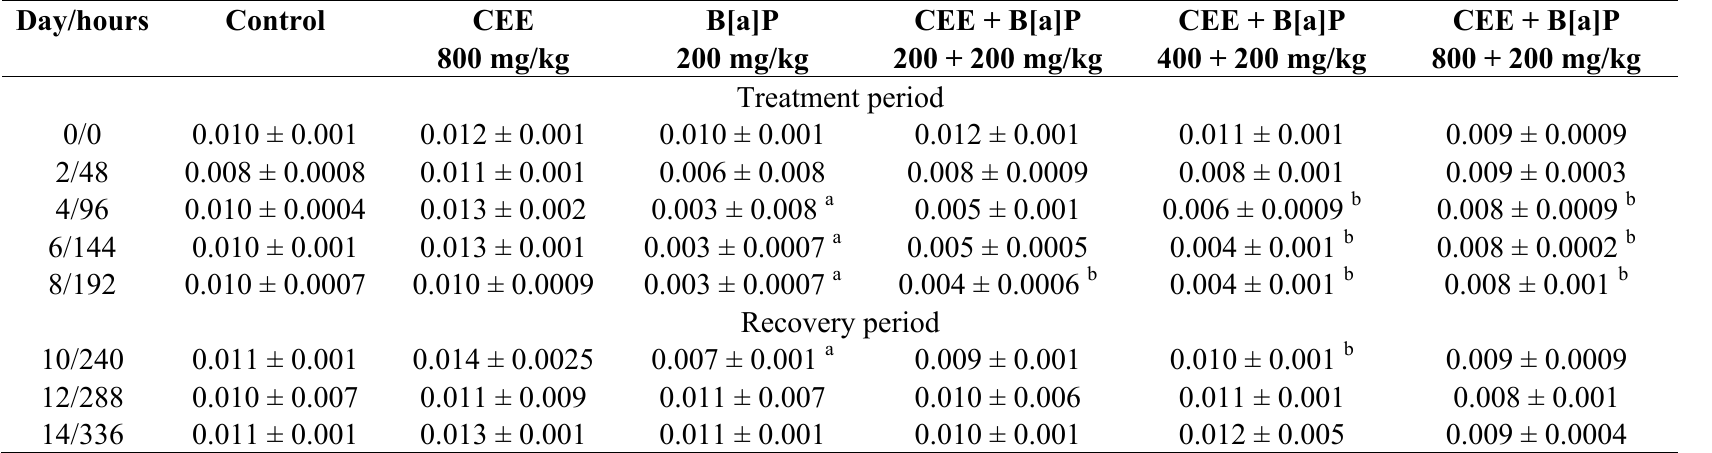
Table 4. Relationship between the number of polycromatic erythrocytes with respect to the number of normochromatic erythrocytes (PE/NE